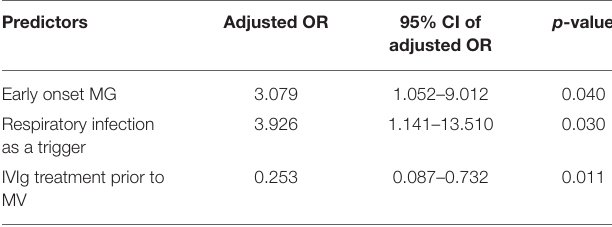
TABLE 2 | The multivariable analysis for predictors of progression to